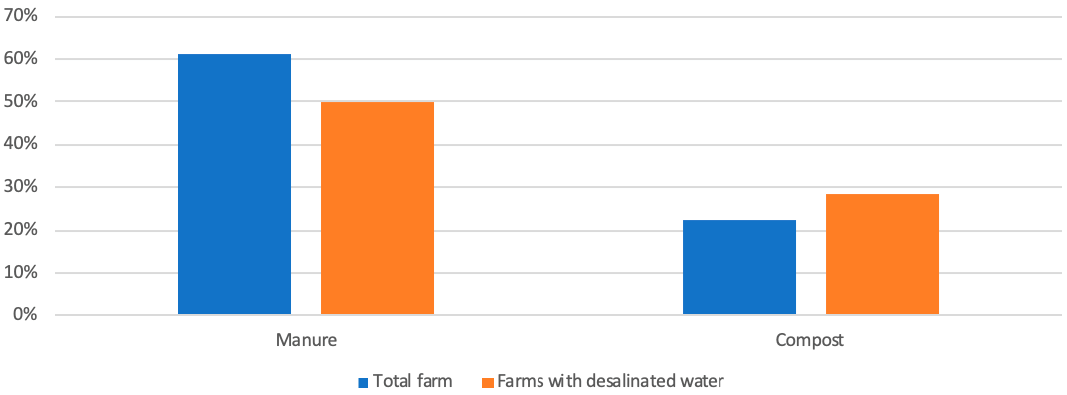
Figure 9. Manure and compost use in farms in the study area. Source: Own elaboration.